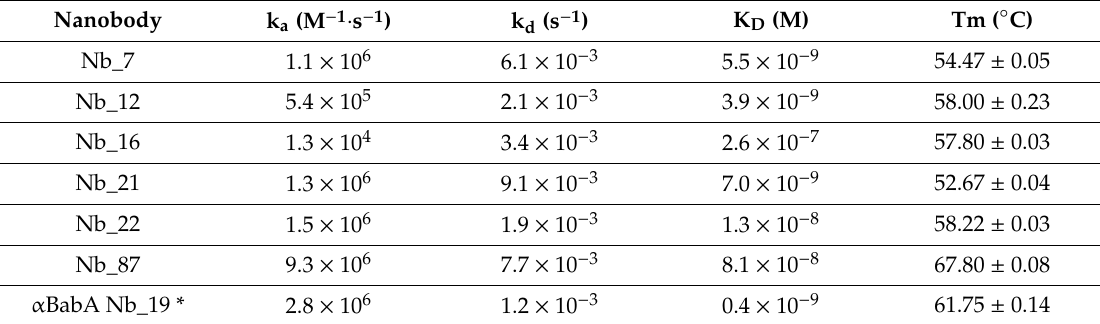
* The binding parameters for α BabA Nb_19 (used as control Nb in in vitro experiments) are for the interaction with its cognate antigen BabA ( H. pylori ’s adhesion